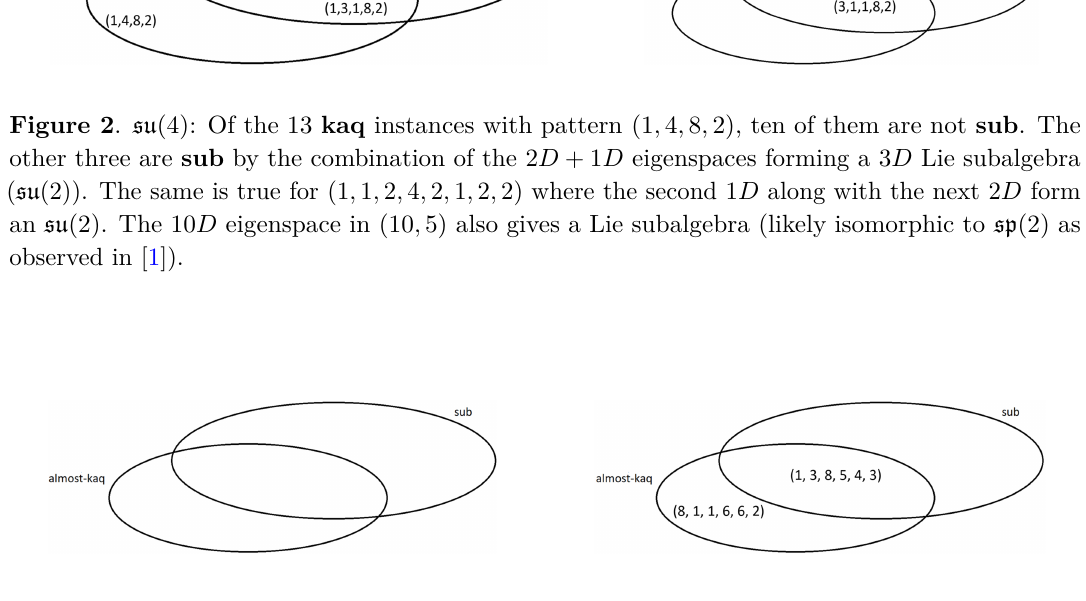
Figure 3 . su (5) : Only L 26 results has almost- kaq patterns (tables 4, 9). (8 , 1 , 1 , 6 , 2) is not sub , while (1 , 3 , 8 , 5 , 4 , 3) is sub by the combination of the 1 D + 3 D + 3 D eigenspaces.